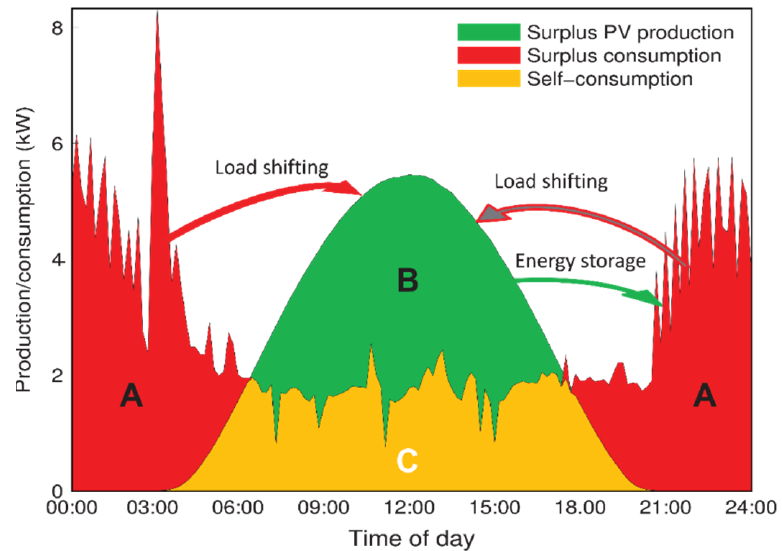
Figure 3. Self-consumption and self-sufficiency load region indexes [16].